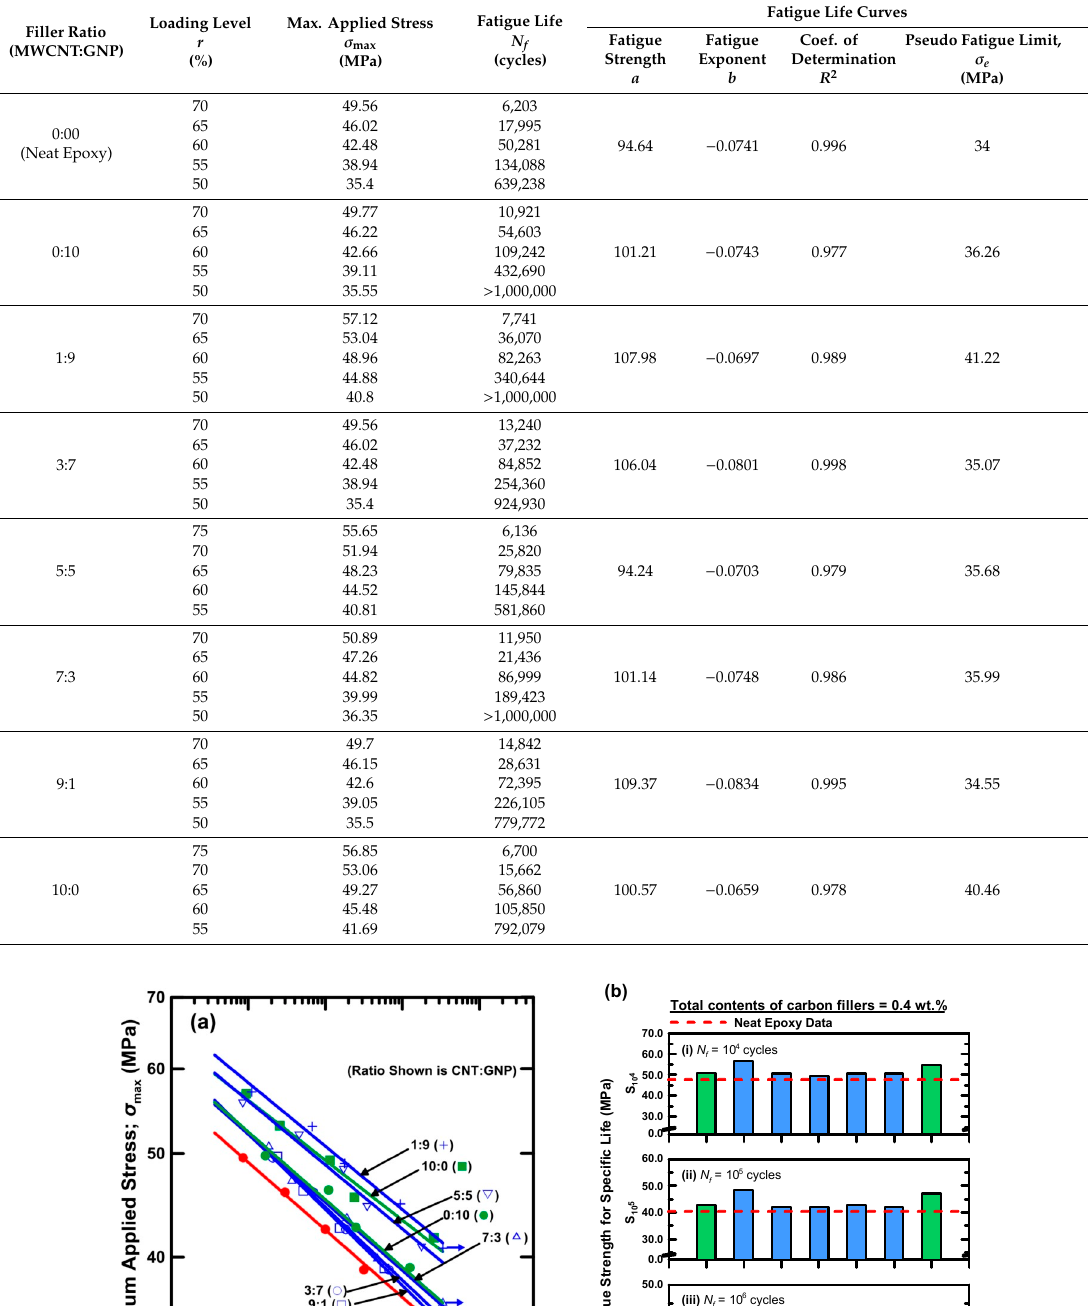
Table 4. Experimental results of fatigue tests performed on the study nanocomposites with various MWCNT / GNP ratios.